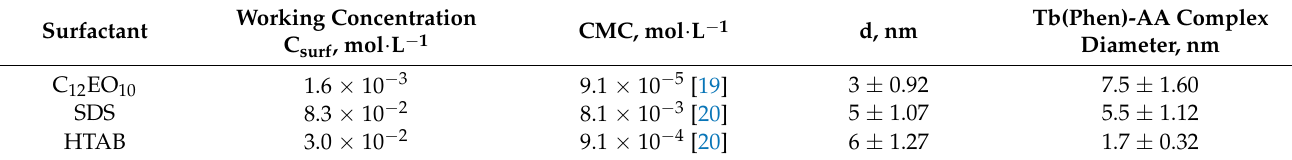
Table 1. Surfactant